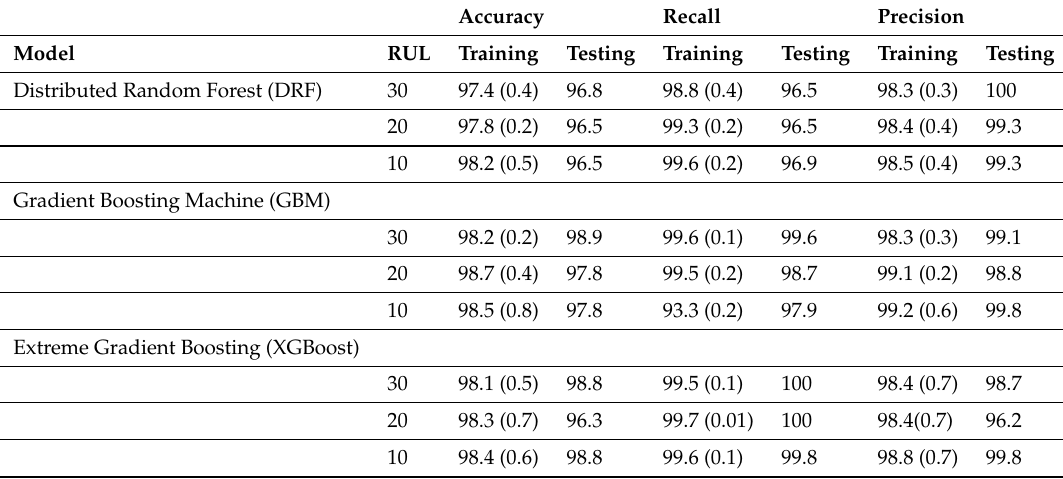
Table 2. Accuracy, Recall and Precision metrics of GBM, DRF and XGboost calculated on training cross-validation (CV) and testing data sets. All metric values (accuracy, recall, and precision) are multiplied by 100. The Standard deviation of training CV is reported in parentheses. The bold letter shows the optimal classifier of each model (GBM, DRF and XGboost) tested on different RUL. Accuracy Recall Precision Model RUL Training Testing Distributed Random Forest